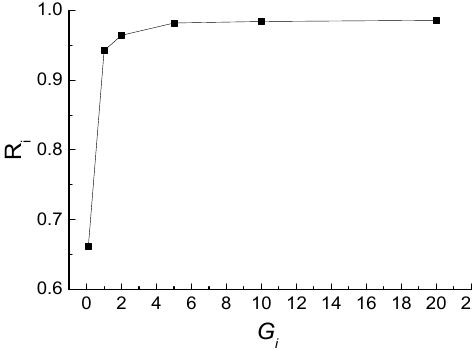
Figure 19. Relationship between stress recovery ratio and shear modulus ratio.